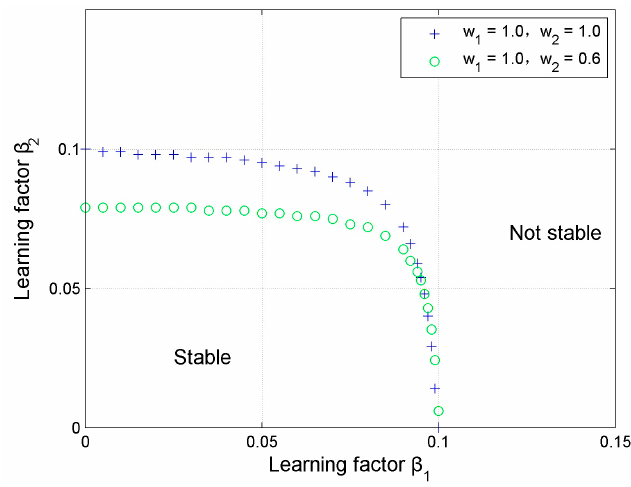
Figure 4. The influence of learning factors on game stability.